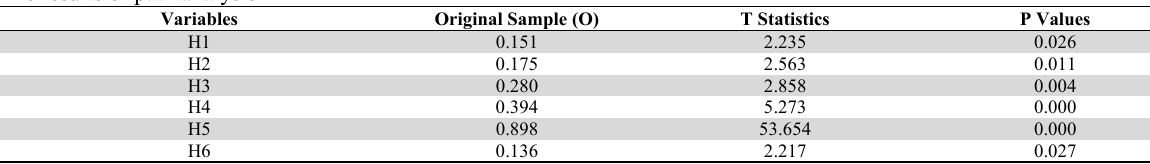
The results of path